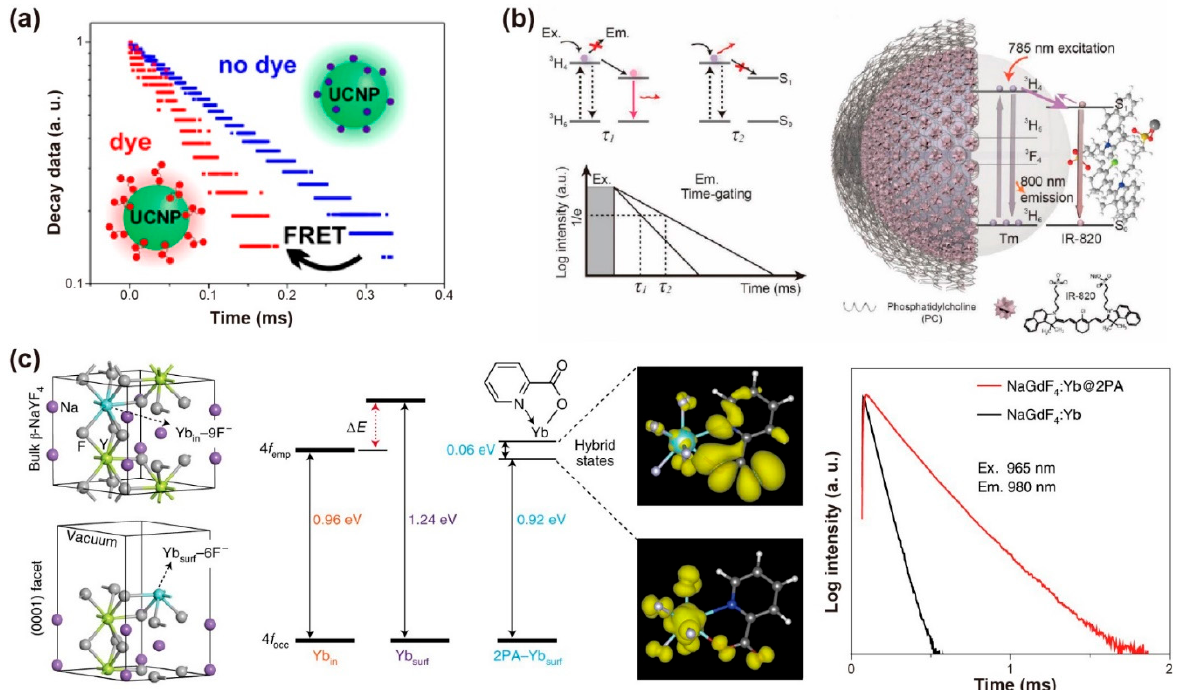
Figure 5. ( a ) Schematic diagram of the lifetime changing due to the existence of FRET process from UCNPs to dye molecules. Reproduced with permission from [54]. Copyright 2017, American Chemical Society. ( b ) Schematic representation of the structure of the NaYF 4 :Tm@PC-IR-820 nanocomposites, the absorbance and emission in the same transition ( 3 H 6 – 3 H 4 ) of NaYF 4 :Tm nanoparticles and the variation of lifetime affected by the amount of IR-820 dye molecules. Reproduced with permission from [55]. Copyright 2019, WILEY-VCH. ( c ) The optimized structure shows ytterbium atoms located in the interior (Yb in ) and exterior (Yb surf ) position, the simulated 4f energy levels of ytterbium atoms, the spatial distribution of the charge densities for coupling states and the lifetime decay curves of Yb 3+ at 980 nm with and without 2PA capping on the NaGdF 4 : 5%Yb nanoparticles (10 nm) excited at 965 nm. Reproduced with permission from [59]. Copyright 2021, Nature Publishing Group.